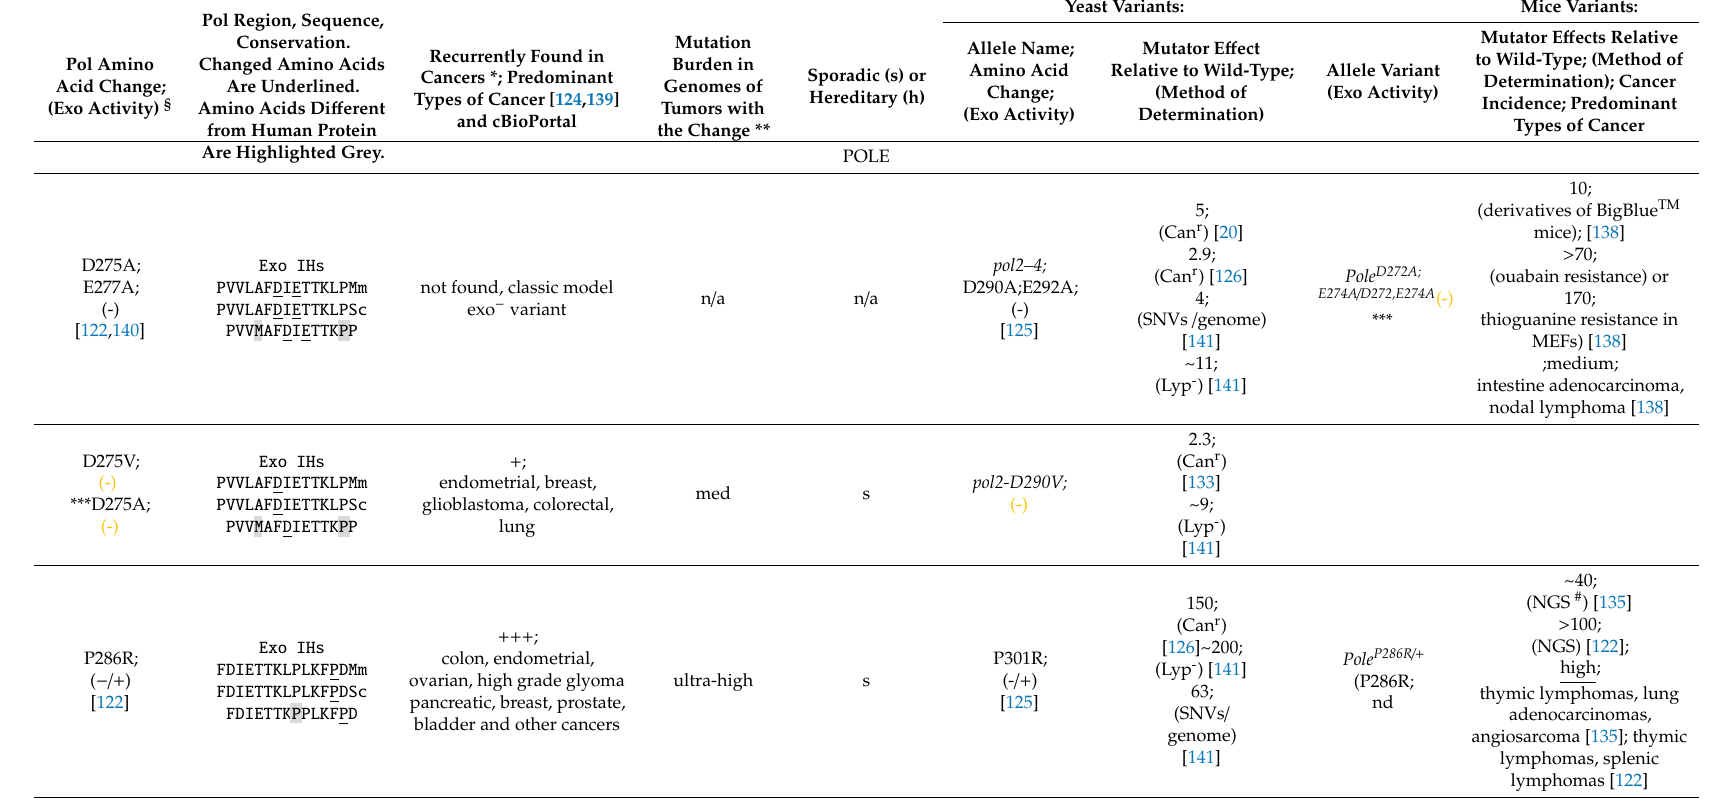
Table 2. Examples of mutator and carcinogenic potential of POLE and POLD1 exo domain mutations in humans and in model